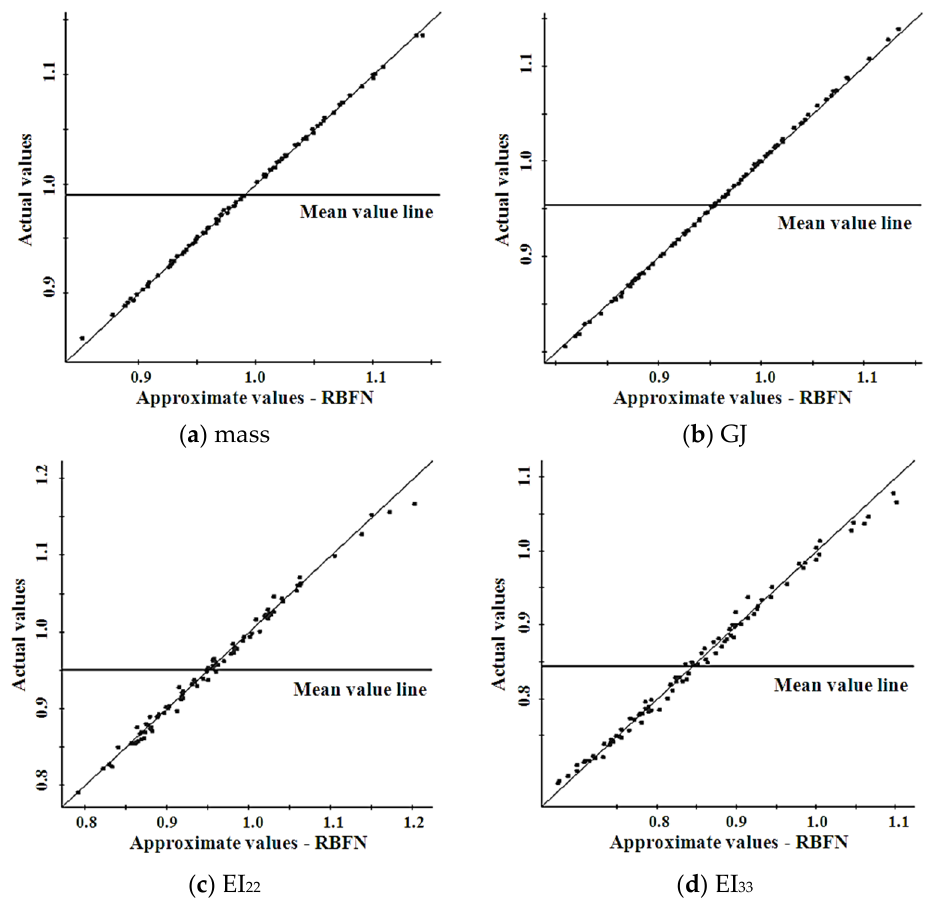
Figure 15. Error scattering analysis for design performance functions. Table 5. Results of accuracy according to variation of training data.